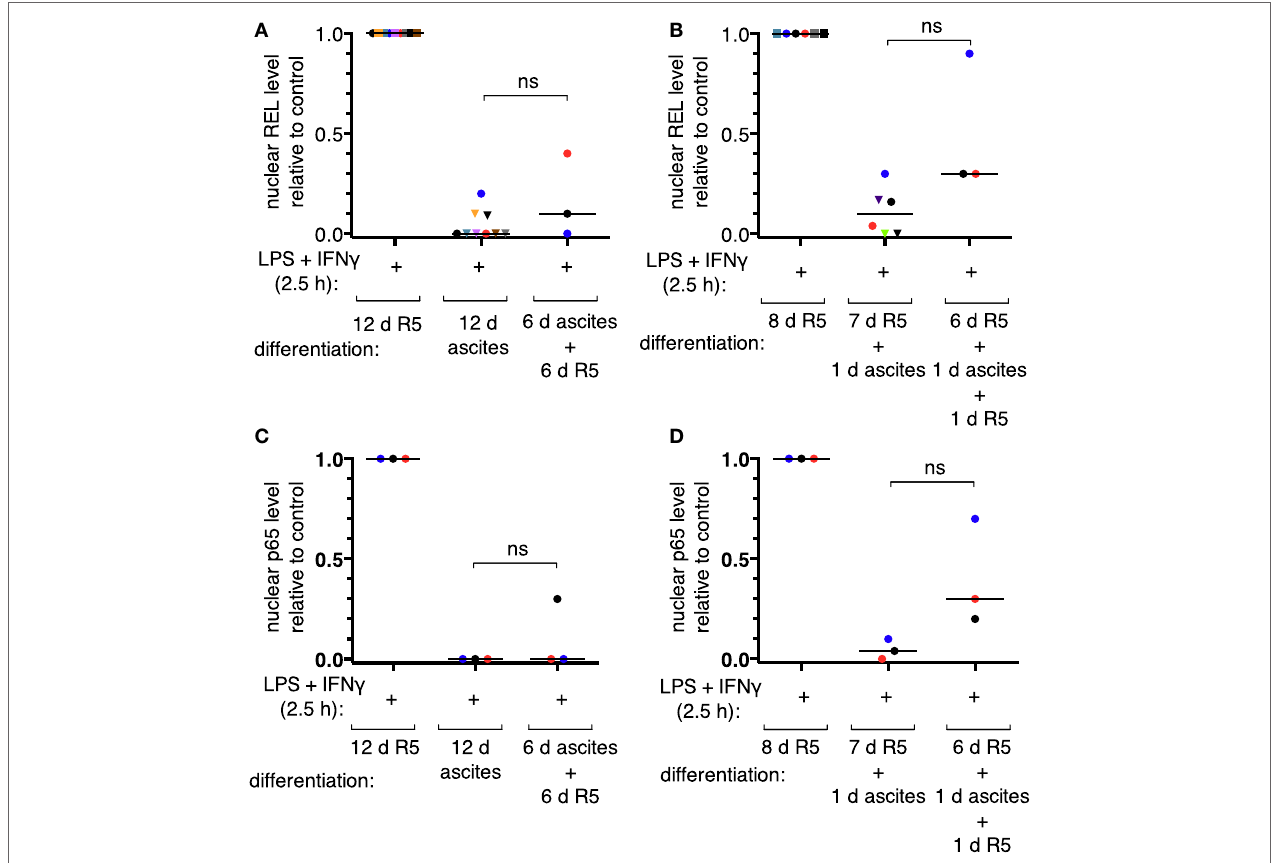
FigUre 3 | Ascites impairs inducible nuclear translocation of REL and p65 in monocyte-derived macrophages. MDMs were differentiated in R5 medium or in ascites and cultivated consecutively as indicated. Cells were incubated with LPS and IFN γ for 2.5 h or their respective solvents (vehicle), harvested, and subcellular fractionation was performed. After immunoblotting, chemoluminescence was measured, nuclear levels of REL were calculated relative to the R5 control population after long-term ascites exposure with ( N = 9) or without ( N = 3) ascites withdrawal (a) or after short-term exposure (B) , respectively ( N = 6 or N = 3 as plotted). Nuclear p65 levels were analyzed in a subset of the same samples ( N = 3) accordingly (c,D) . Each color denotes a biological replicate (combination of healthy donor and randomly chosen ascites sample). Dots mark samples which were probed for both REL and p65 nuclear translocation. The code is consistent between panels within this figure. Median values are indicated by horizontal bars. Statistical significances were calculated with paired t -tests; ns, not significant ( P >